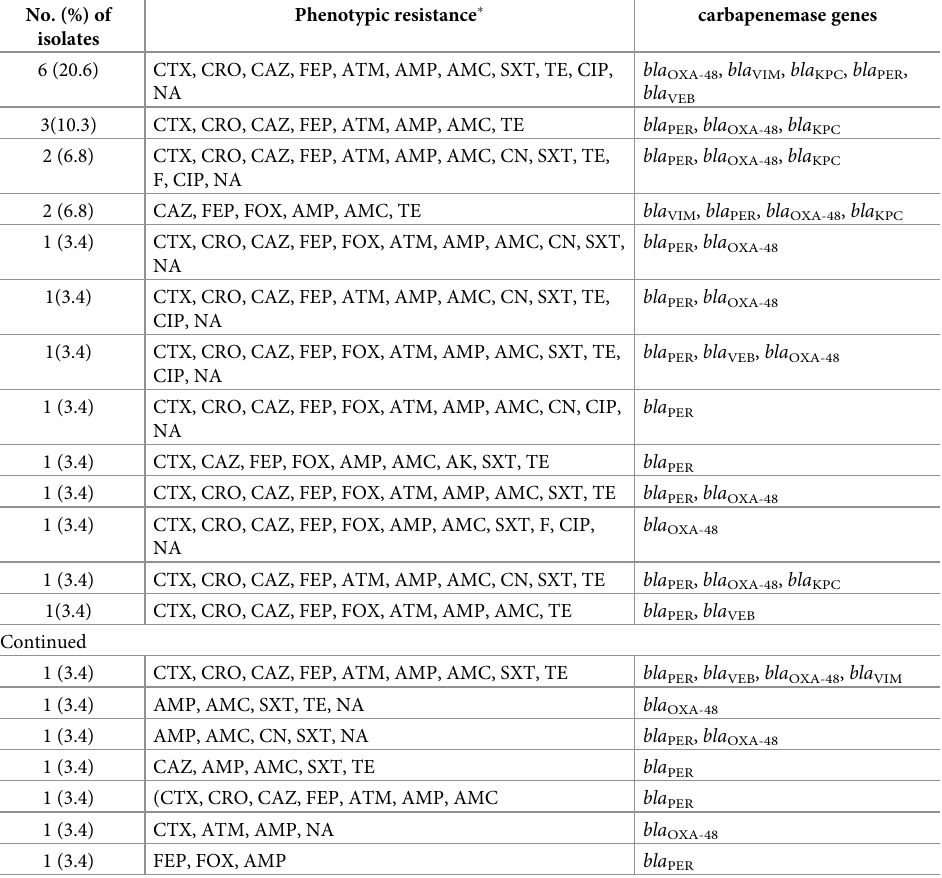
Table 10. Phenotypic and genotypic resistance patterns of 29 MDR carbapenemase producing B2 UPEC isolates. No. (%) of